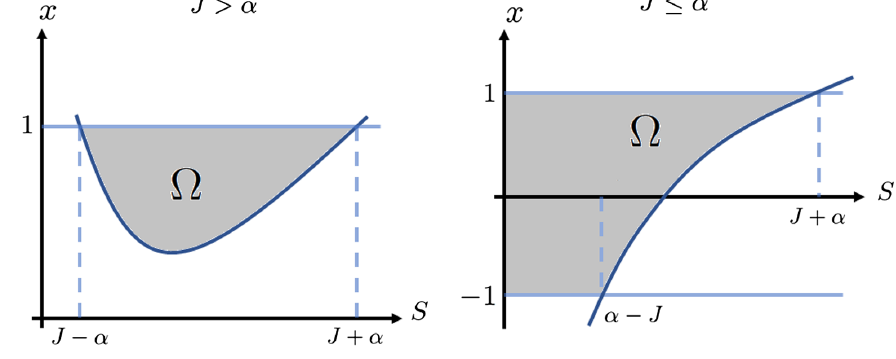
FIG. 7. Two options for Ω , with t ¼ α